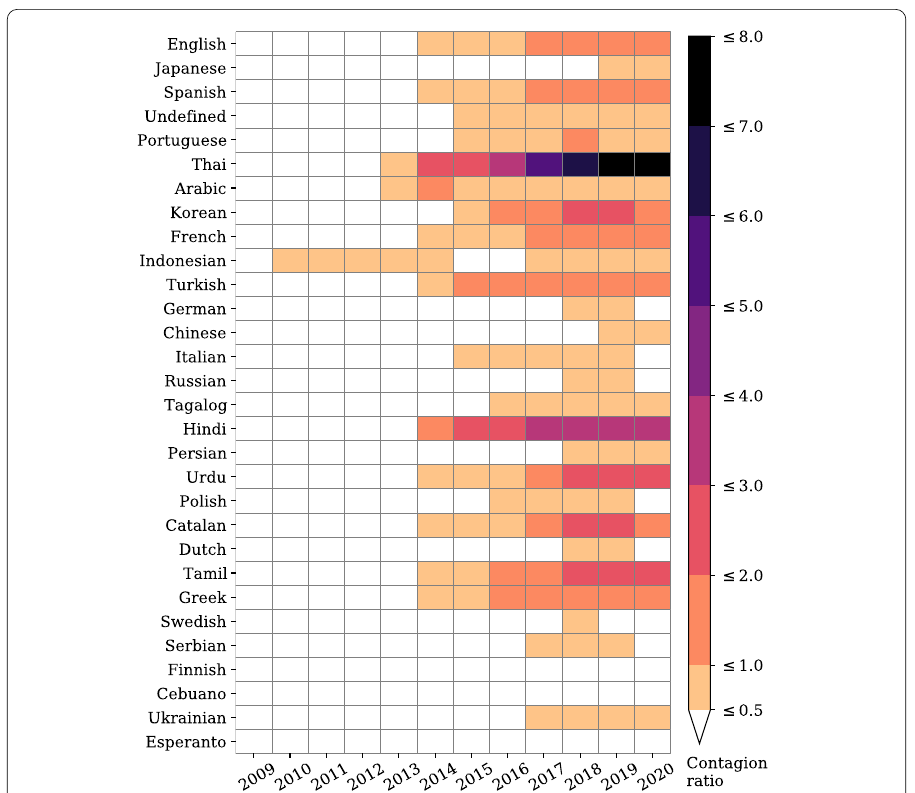
Figure 6 Timelapse of contagion ratios. The average ratio is plotted against year for the top 30 ranked languages of 2019. Colored cells indicate a ratio higher than 0.5 whereas ratios below 0.5 are colored in